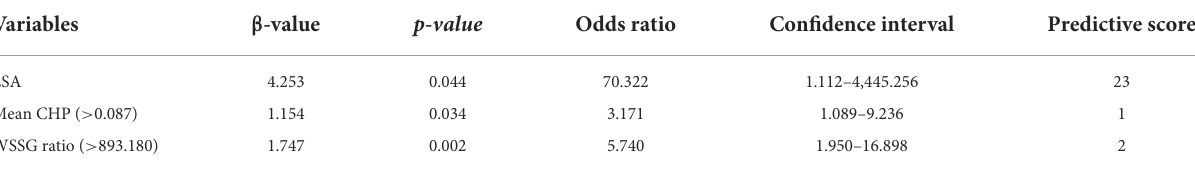
TABLE 3 The result of conditional multivariable logistic regression. Variables Odds ratio Confidence interval Predictive